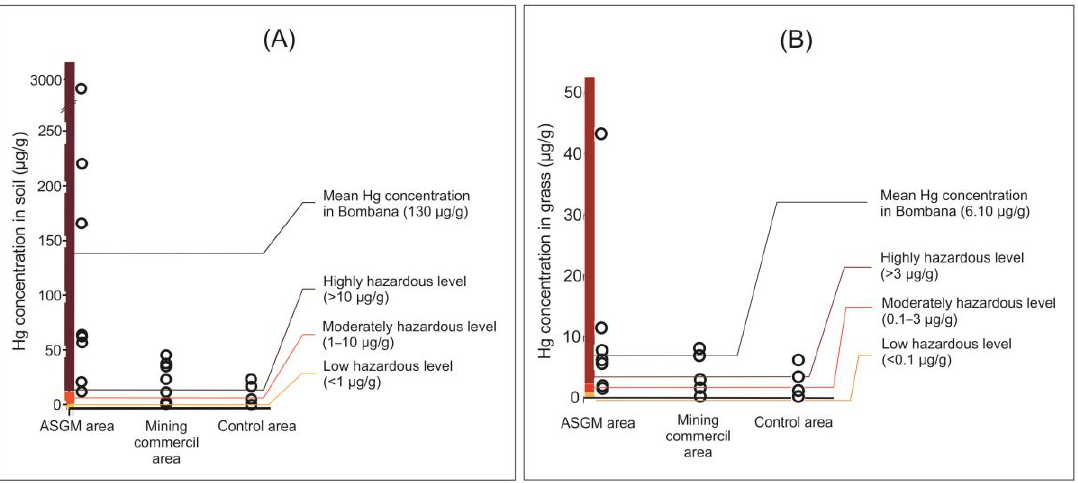
Figure 1. The regulatory guidelines and the hazard potential ( A ) distribution of soil sample and Hg level according to the MPA Dutch standards for soils and ( B ) distribution of forage plants Hg level according to the critical limits for Hg.